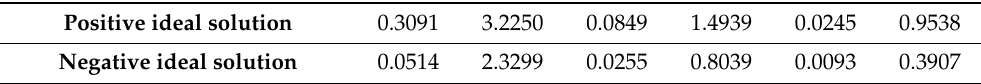
Table 14. Matrix of ideal positive and negative TOPSIS solutions.